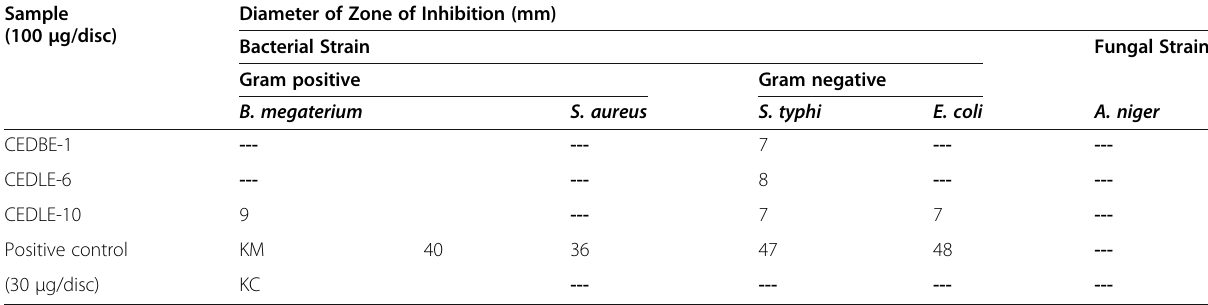
Table 2 Antimicrobial Screening of Isolated Compounds Sample (100